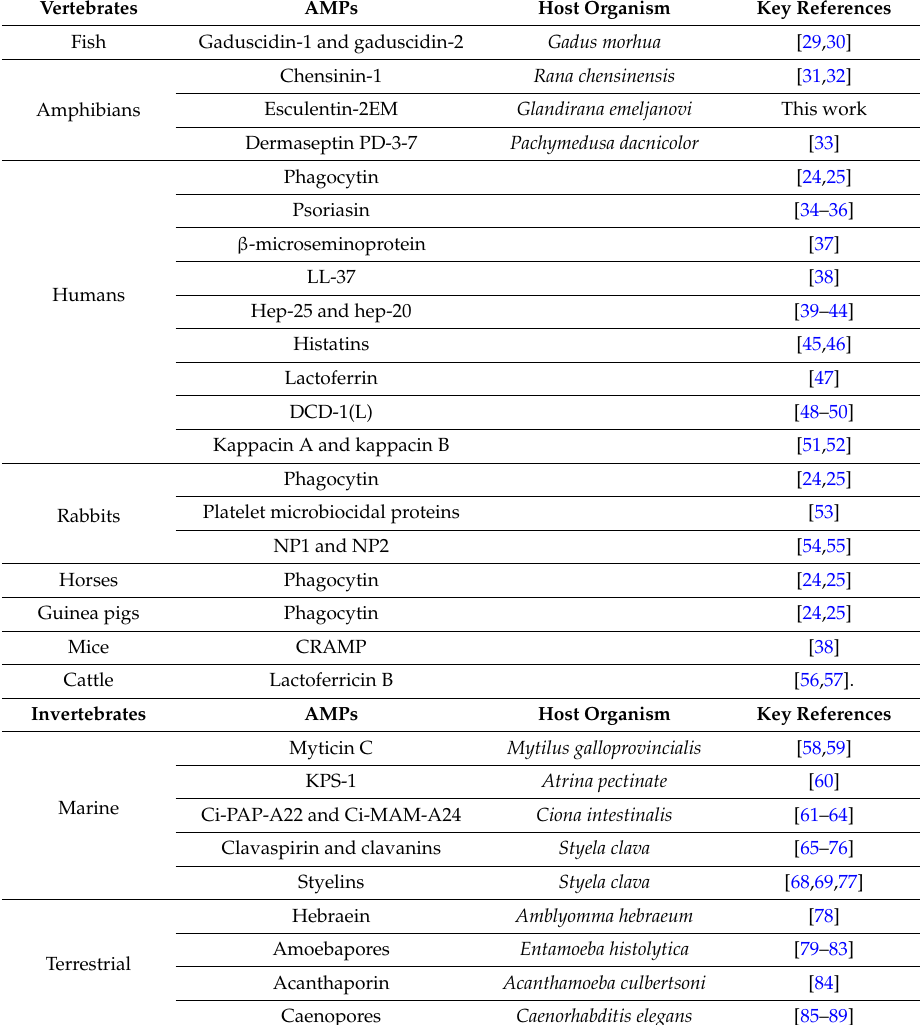
Table 3. AMPs with pH dependent